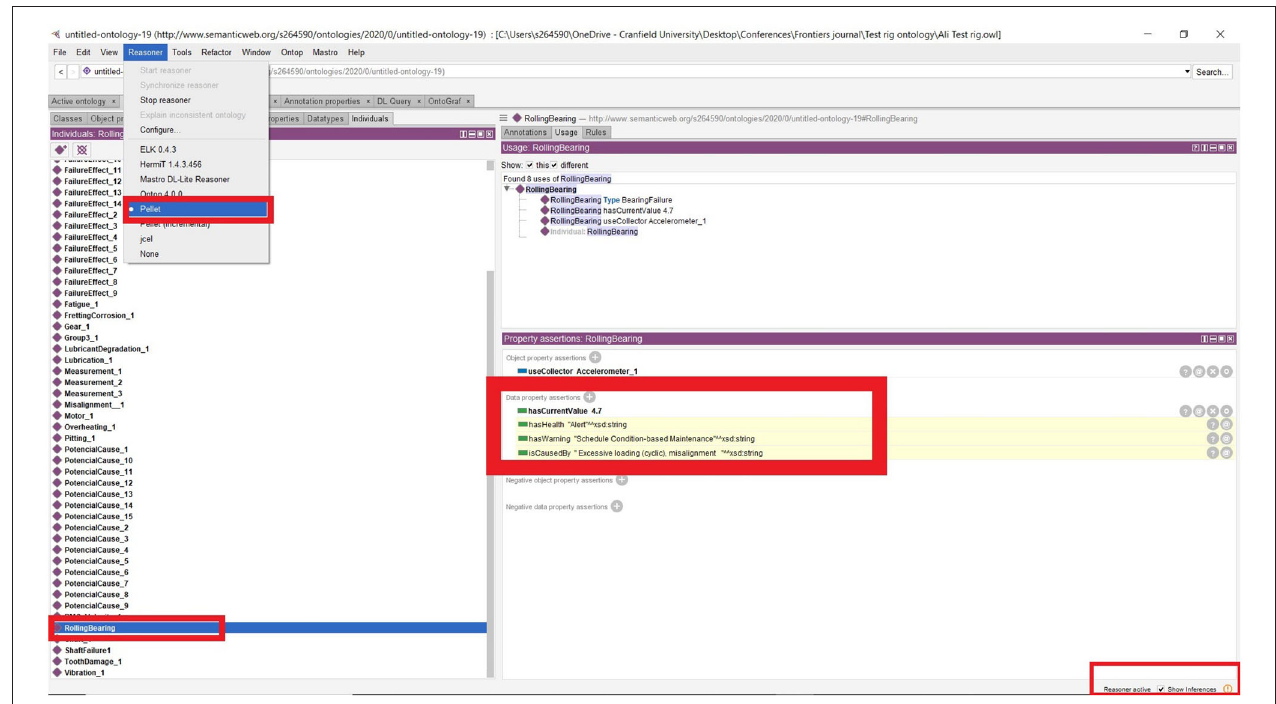
FIGURE 6 | SWRL rules for generating warning and potential